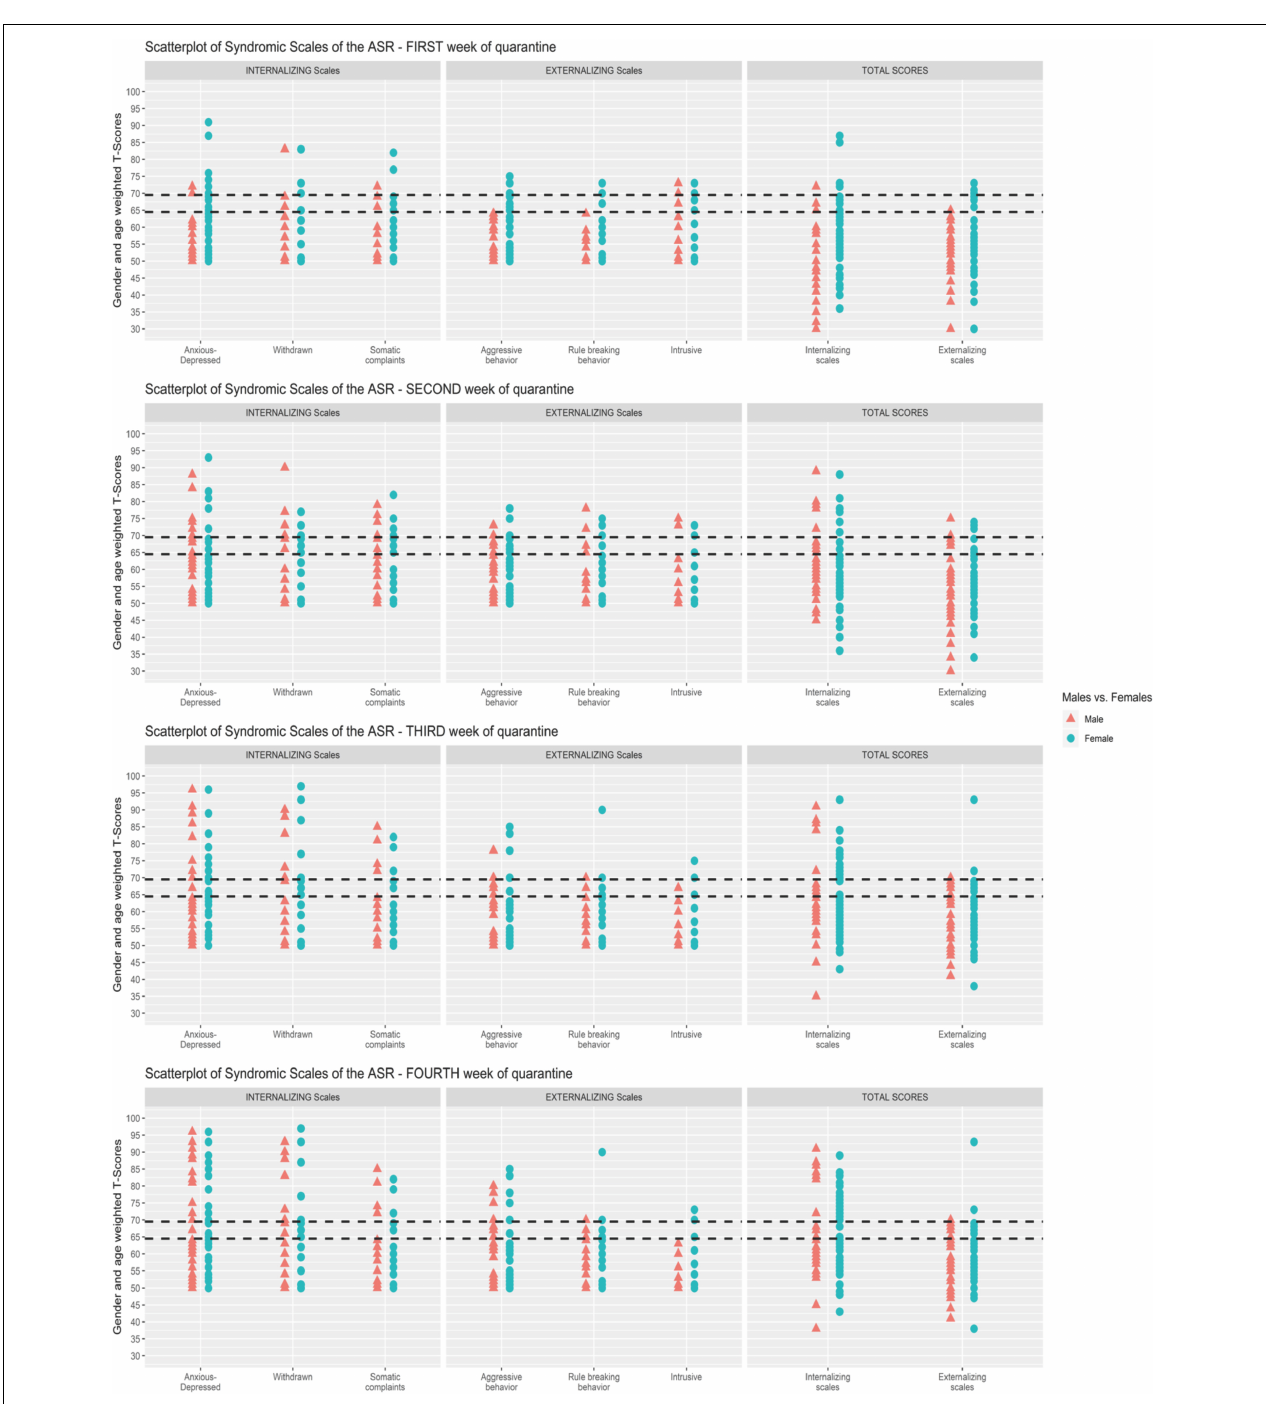
FIGURE 1 | Scatterplot of Syndromic Scales of the Adult Self-Report (ASR) for each week of quarantine.